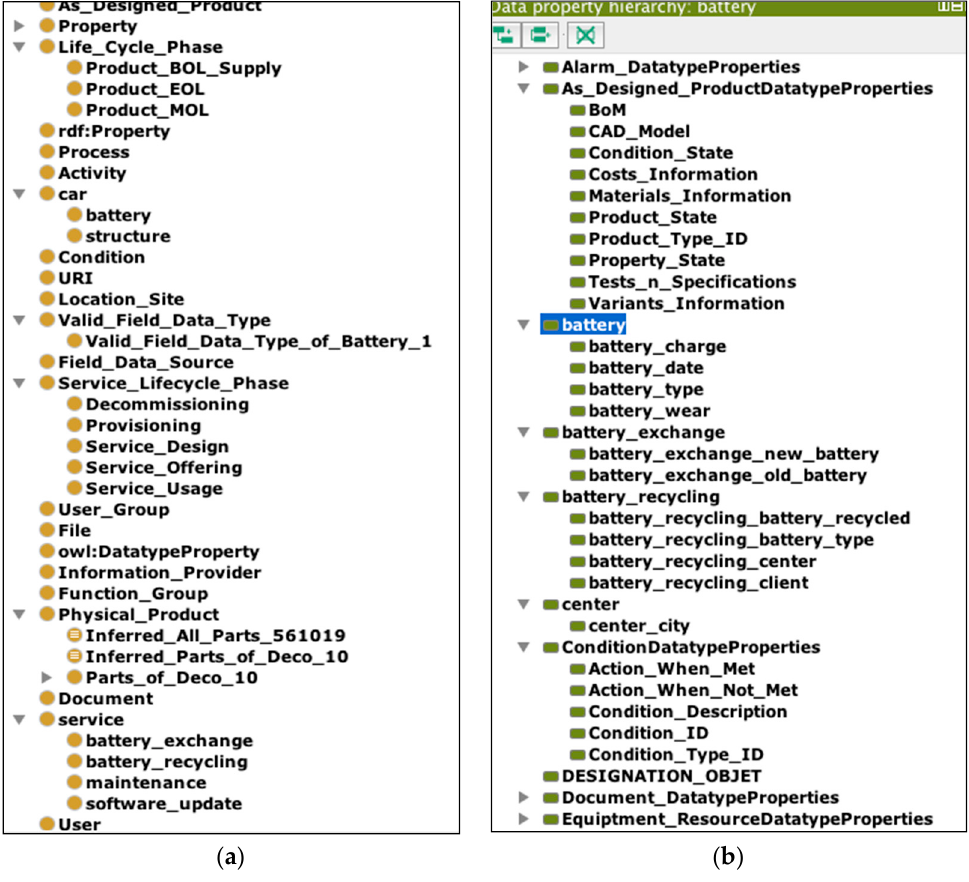
Figure 16. PSLO with the domain-specific ontology of the electric car service.